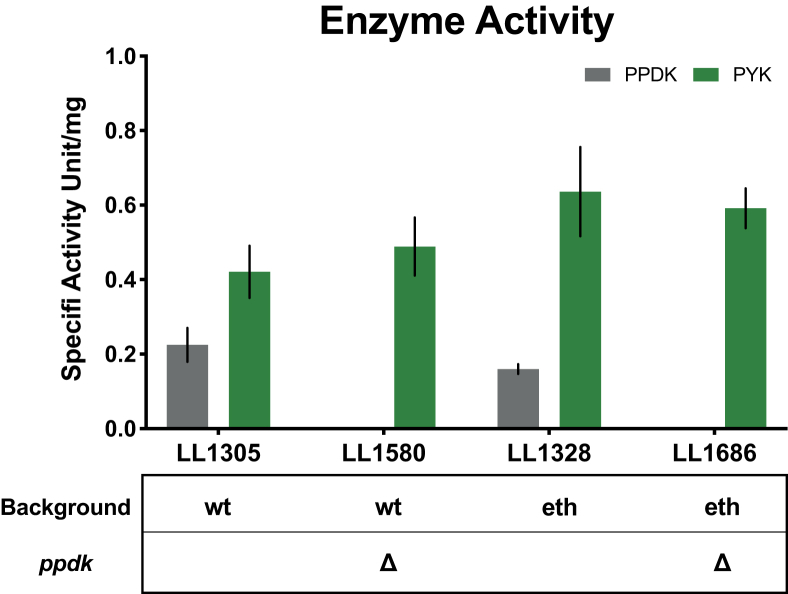
Enzyme activities of T. saccharolyticum strains. Pyruvate kinase (PYK, shown in green) and pyruvate phosphate dikinase (PPDK, shown in grey) were measured in wild type strain (LL1305), homoethanologen strain (LL1328) and the Δppdk strains (LL1580 and LL1686). wt stands for wild type, eth stands for homoethanologen. All strains were grown in MTC-6 medium containing 5 ​g/L initial cellobiose and collected at mid-log phase of growth. Error bars represent one standard deviation (n ​= ​6).